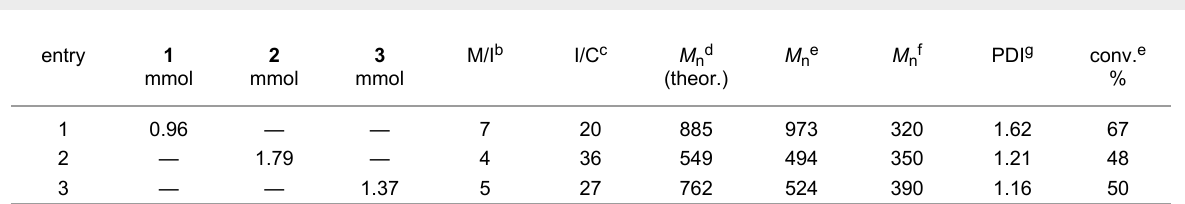
Table 2: Ring-opening polymerization of rac -lactide in the presence of alcohol initiators [benzyl alcohol ( 1 ), ethylene glycol ( 2 ), glycerol ( 3 )] a , initiated in vacuo at 75 °C for 75